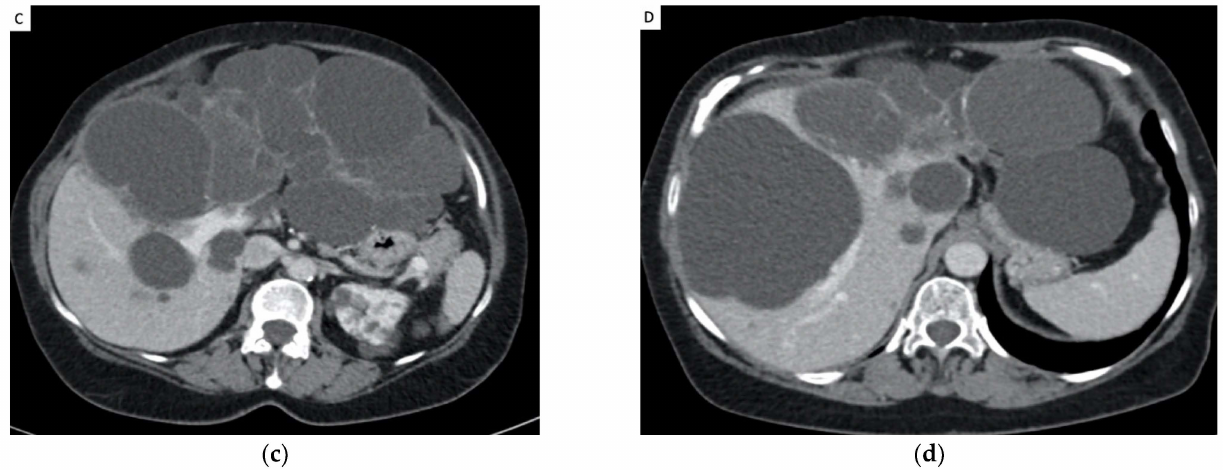
Figure 1. ( a ) arteriography of the coeliac artery showing well developed hepatic artery deviated by the cysts without parenchymography of the left liver. ( b ) Portography showing permeable splenic and portal vein, occlusion of the left portal and right anterior portal vein (arrow), and permeability of the right posterior portal vein (Star). ( c , d ): CT scan showing good correlation with the arteriography and portography. hepatic parenchyma is completely replaced by cysts in segment II, III and